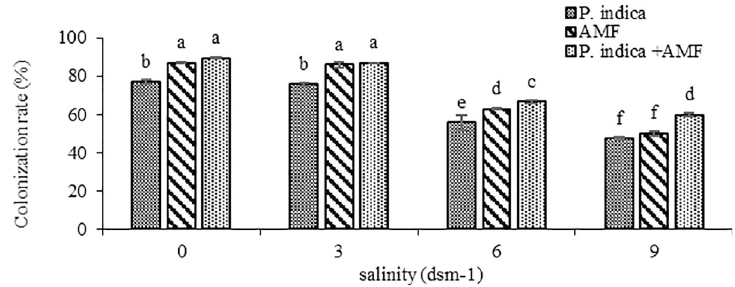
Fig 3. Effect of salinity on root colonization ( P . indica , AMF and co-inoculation) in peppermint. In each figure, means with the same letter are significantly different according to LSD test at P <